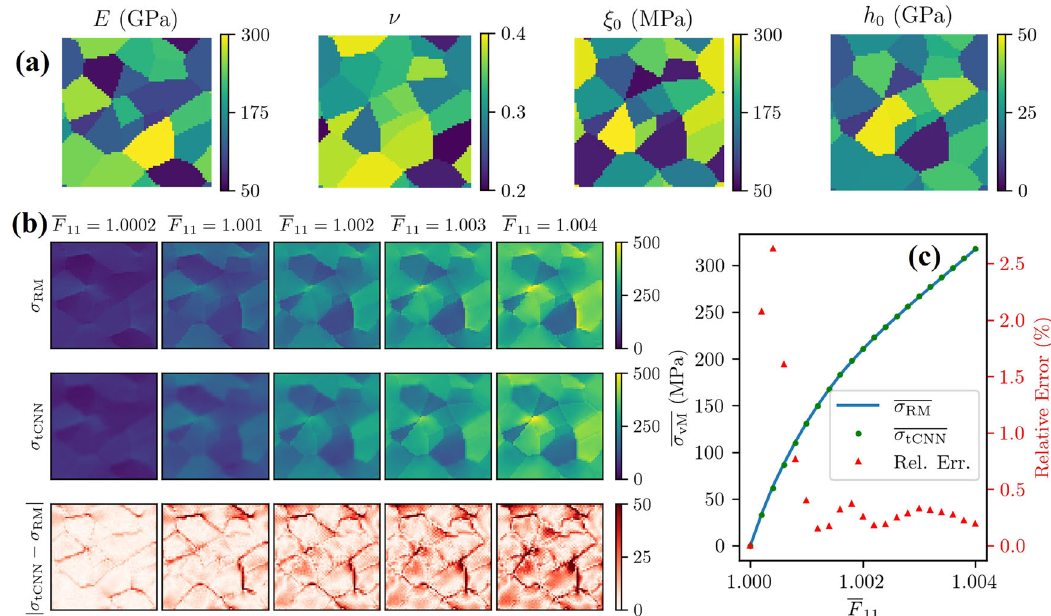
Fig. 3 Twenty-grain test microstructure subject to uniaxial extension along the horizontal axis. a Young ’ s modulus E , Poisson ’ s ratio ν , initial fl ow resistance ξ 0 , linear isotropic hardening modulus h 0 . b Results for σ RM (above), σ tCNN (middle), ∣ σ tCNN − σ RM ∣ (below) (all MPa), at different F 11 . c σ RM (blue curve), σ tCNN (green points), and relative error (red triangles) given by 100 ð σ tCNN (cid:3) σ RM Þ = σ RM versus F 11 .